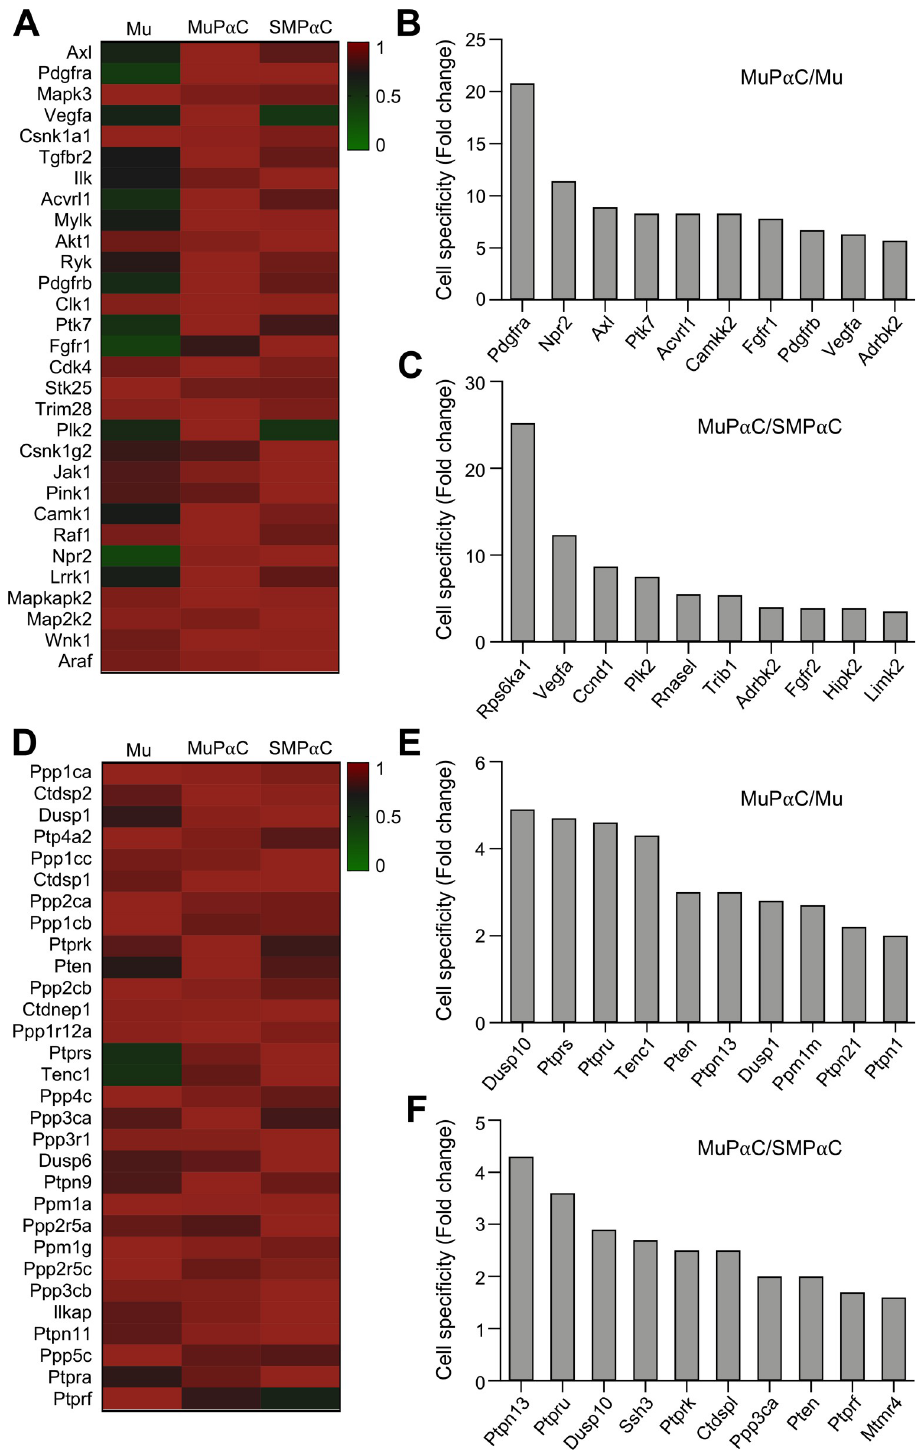
Fig 8. Identification of the protein kinases and phosphatases predominantly expressed in colonic MuP α C. A : A heat map of the protein kinases enriched in MuP α C compared to mucosal tissue (Mu) and smooth muscle PDGFR α + cells (SMP α C). B : MuP α C-specific protein kinases compared to Mu. C : MuP α C-specific protein kinases compared to SMP α C. Sorted by MuP α C/Mu, cut off 10 fold MuP α C in MuP α C/Mu; sorted by MuP α C/SMP α C,cut off 10 fold MuP α C and 1 fold SMP α C in MuP α C/SMP α C. D : A heat map of the phosphatases enriched in MuP α C compared